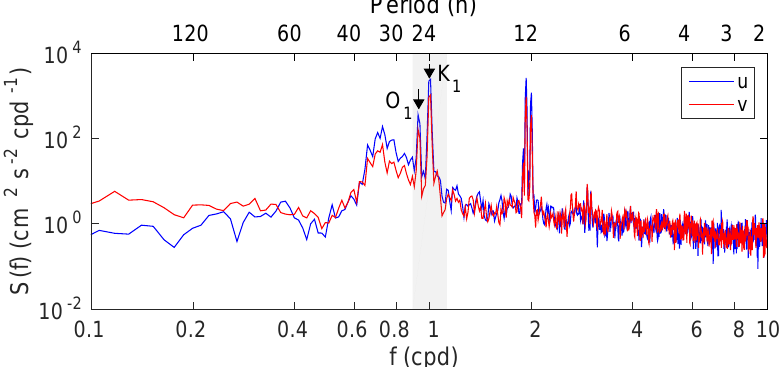
Figure 3. Power spectral density of depth-averaged, rotated u - and v -velocity components at mooring M3. The diurnal tidal frequency band around one cycle per day (cpd) is marked in grey; black arrows indicate frequencies of the K 1 and O 1 tidal constituents.